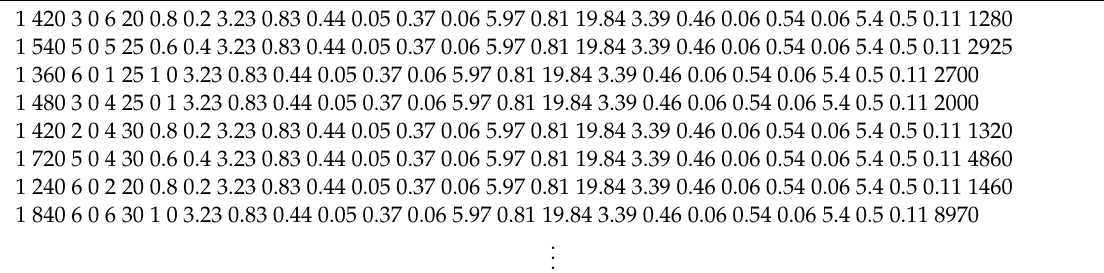
Table 2. Example of training data of DNN model for predicting ore production.